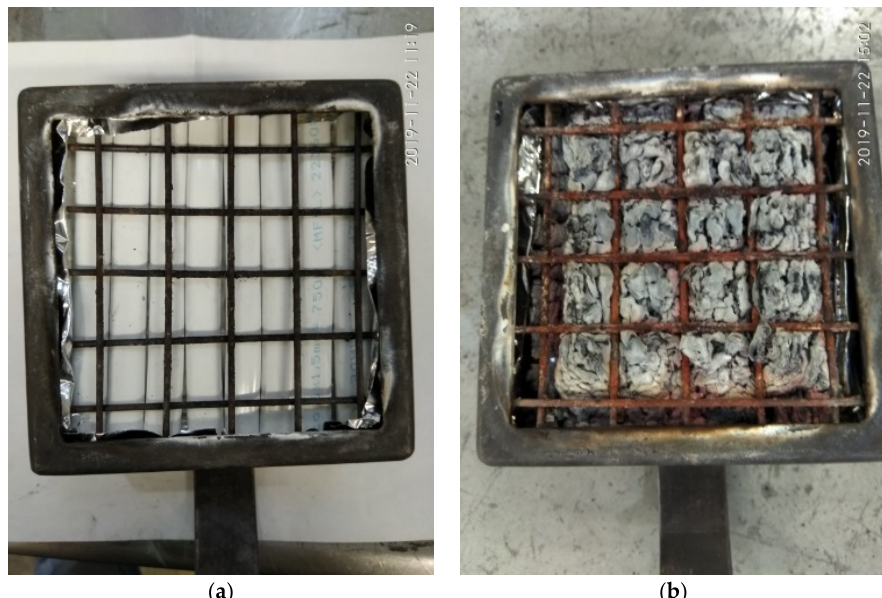
Figure 3. Cable specimen (100 mm × 100 mm) for cone calorimeter testing: ( a ) sample before the test, ( b ) sample after the test).